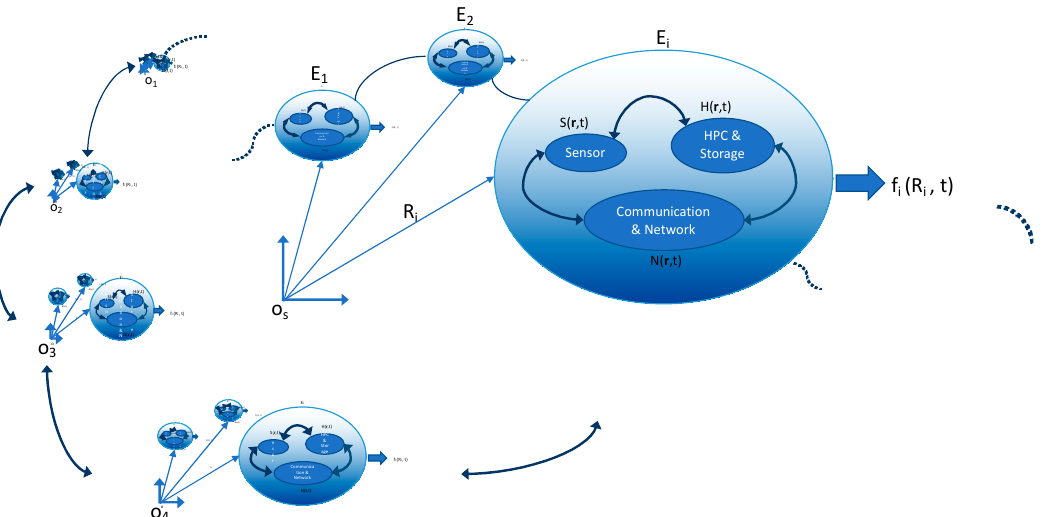
Figure 6. Envisioning a potential variation of the interconnectivity of edge sensors. The nested growth of edge devices may form a system of a coupled dynamical system with fractal self-similarity. The sensor output S can be processed to H and communicated as N with a final output of f for node i located at R i relative to data center O s .